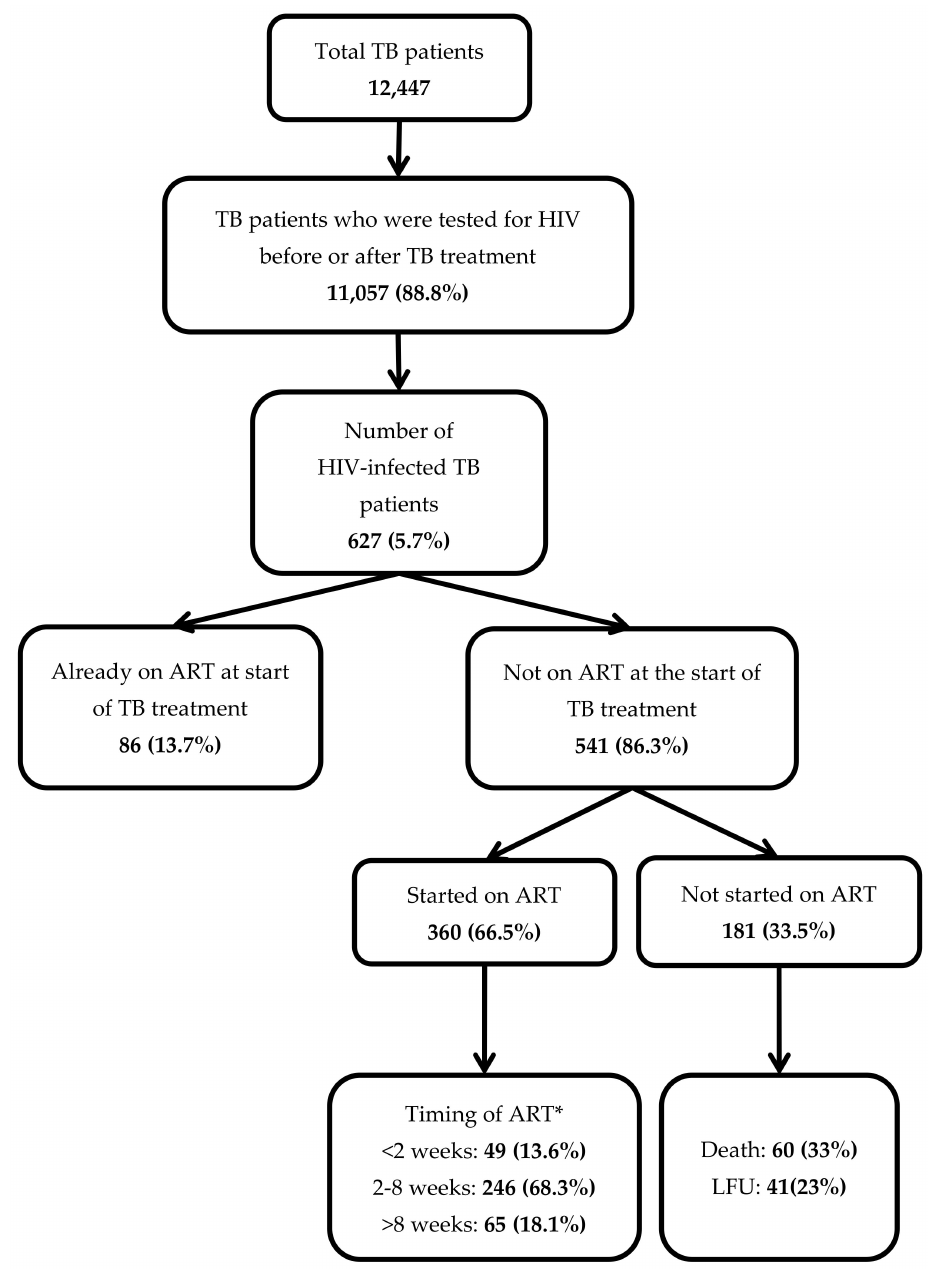
Figure 1. Antiretroviral therapy (ART) uptake and its timing in a cohort of HIV-infected tuberculosis (TB) patients registered in the public health facilities of Ayeyawady Region of Myanmar, between July 2017 and June